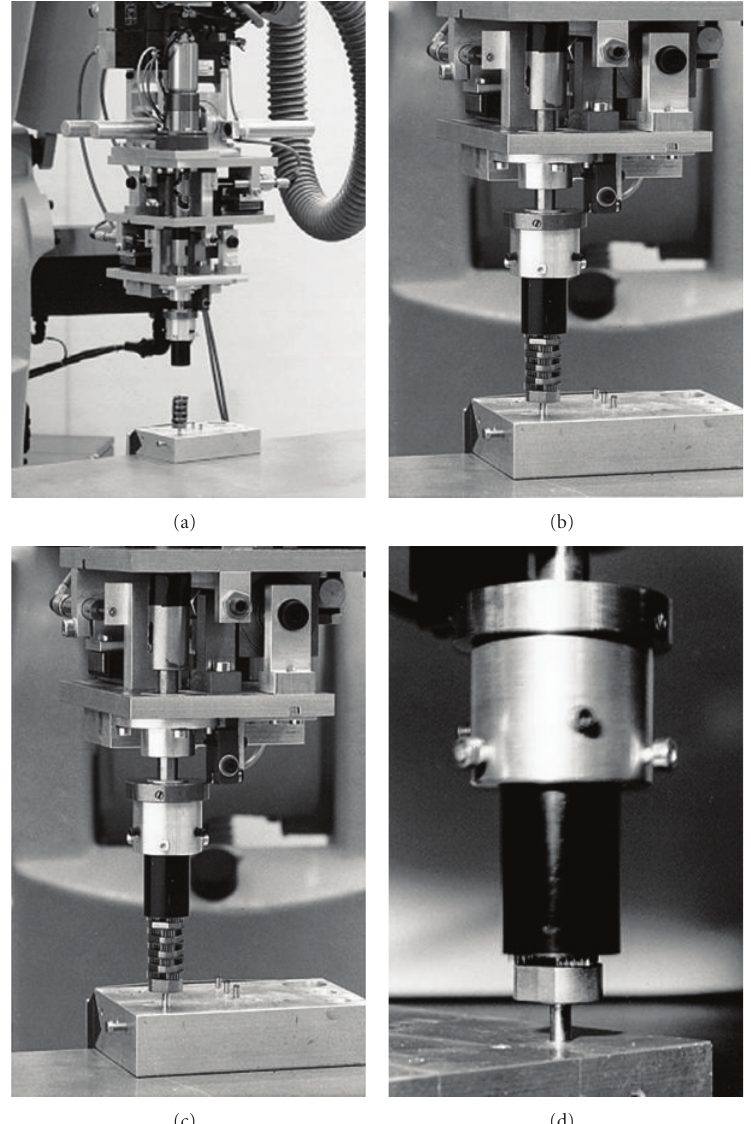
Figure 4: Particular phases of assembly